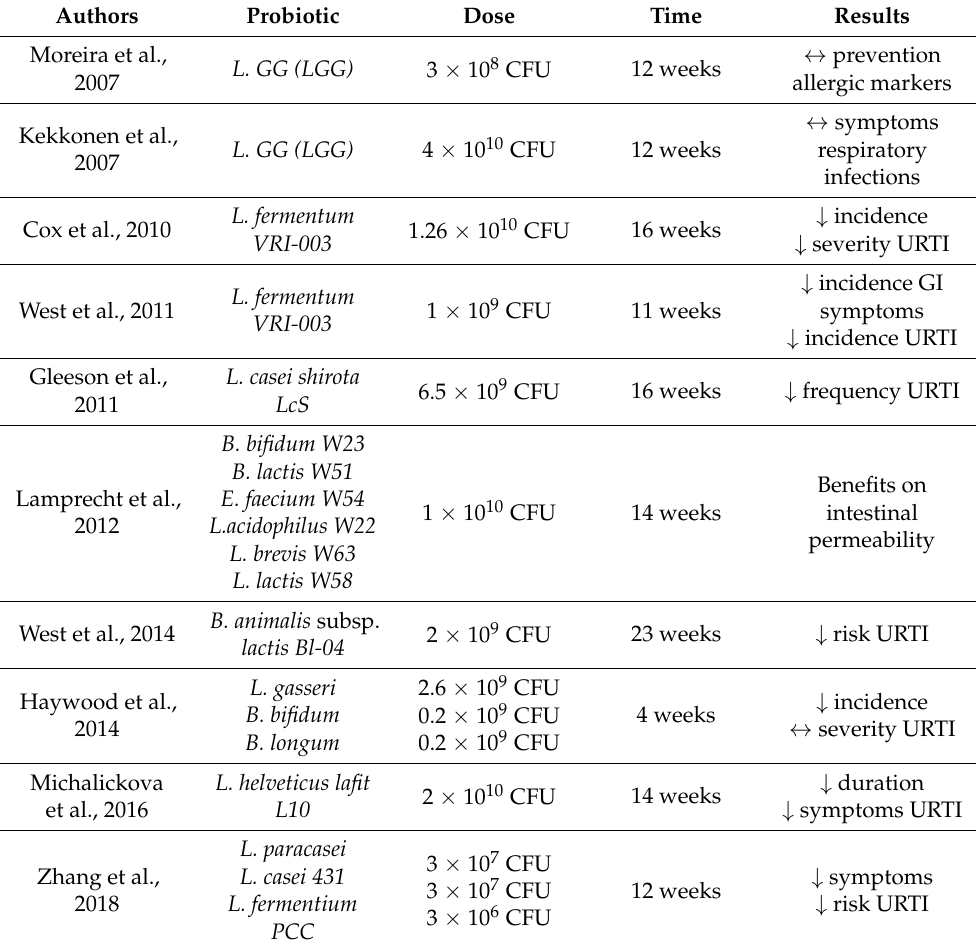
Table 1. Summary table of probiotics and effectiveness on symptoms of